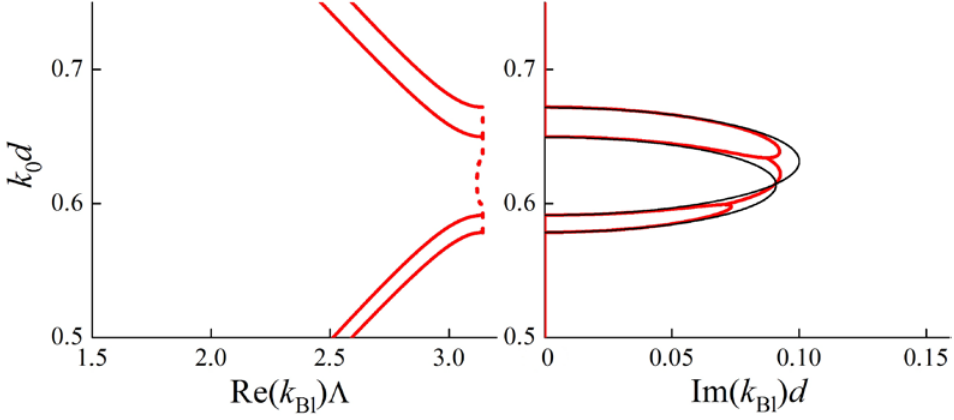
Figure 5. Bloch dispersion curves (red lines) for a PC with the parameters as in Figure 4, but with misaligned optical axes of adjacent layers. A DBG appears at the intersection of the Brillouin BGs. At the frequencies of the DBG both real and imaginary parts of the Bloch wave numbers for different dispersion curves are equal. Black lines being the same as in Figure 4 are shown for reference. The angle between optical axes of the adjacent layers is 0.08 rad. In the left figure for ( ) Re k Λ solid lines correspond to pass bands, Bl dashed lines correspond to band